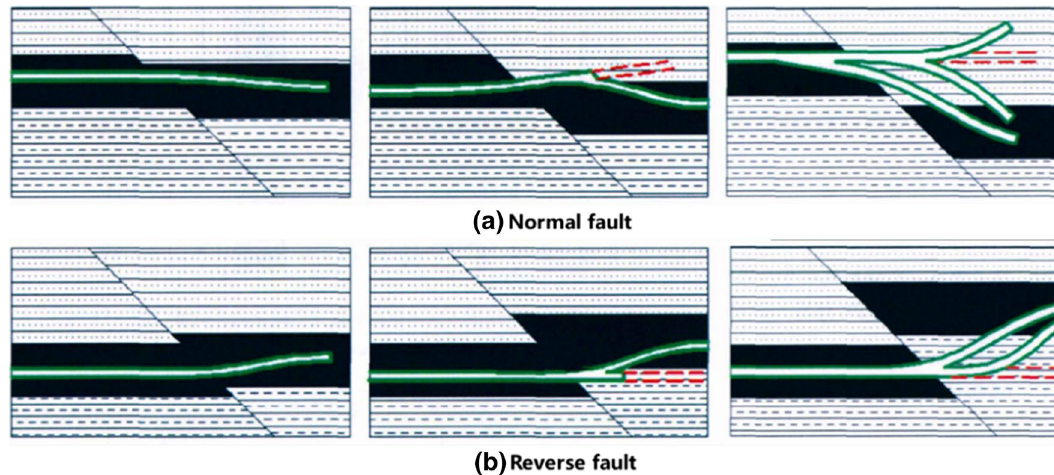
Fig. 22 Trajectory tracking methods in the presence of faults, modified from Zhao